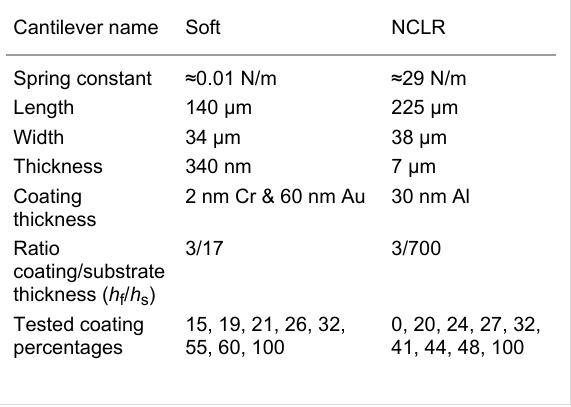
Table 1: Specification of the two types of cantilevers used for this